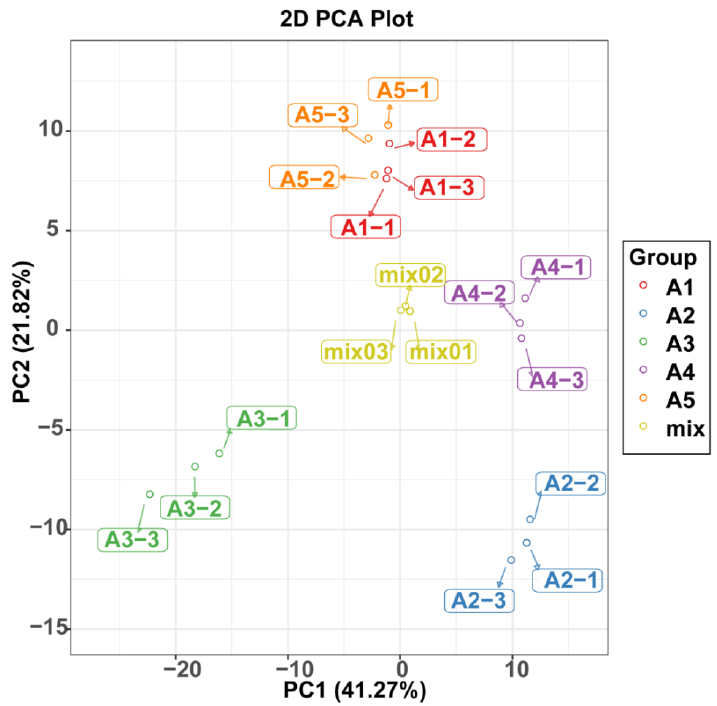
Figure 3. PCA score plot of flavonoid profiles from the five eggplant varieties. 2.3. Comparison of Differentially Accumulated Metabolites among the Five Eggplant Varieties Score plots of the orthogonal partial least-squares discriminant analysis (OPLS-DA) were created to analyze the differences between pairs of the five varieties. High predict- ability (Q2 > 0.9) and strong goodness of fit (R2X and R2Y) of the OPLS-DA models were observed in pairwise comparisons among the five varieties (Figure 4 and Supplementary Figure S1), suggesting the reliability of the metabolic data. Although in the PCA plots A1and A5 gathered near each other, in the OPLS-DA models, A1, A2, A3, A4, and A5 were clearly separated from each other, suggesting major distinctions in the flavonoid metabolic profiles between the different peel color groups.